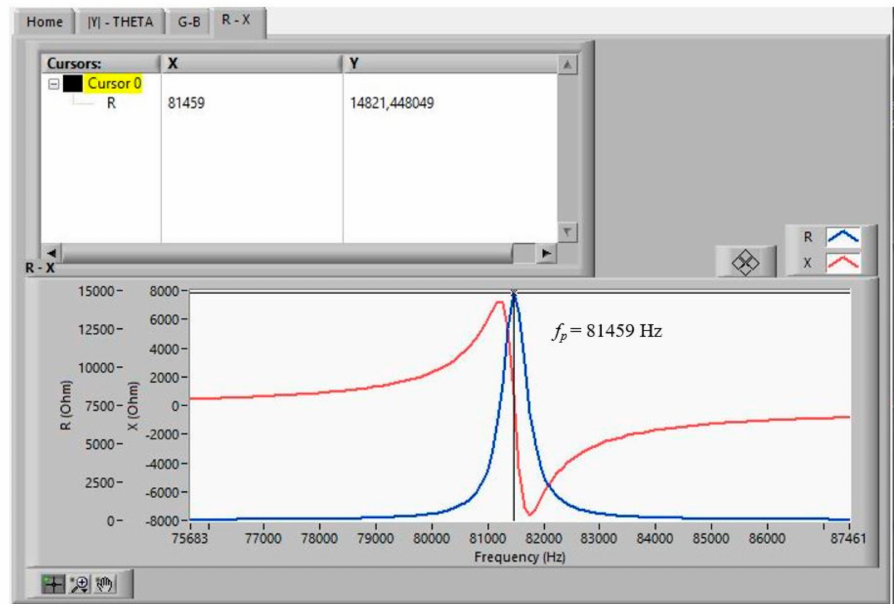
Figure 13. Searched frequencies after the automatic search step: f p